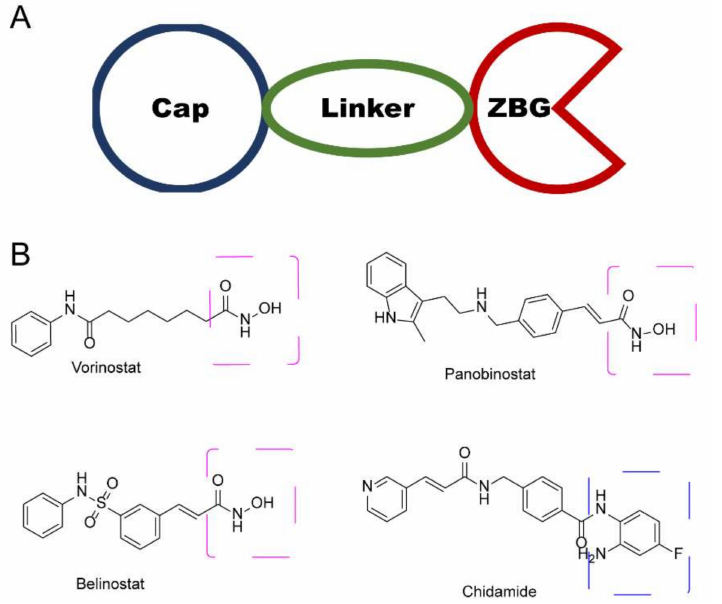
Figure 1. ( A ) General diagram of key HDACi interactions. ( B ) Representative FDA-approved